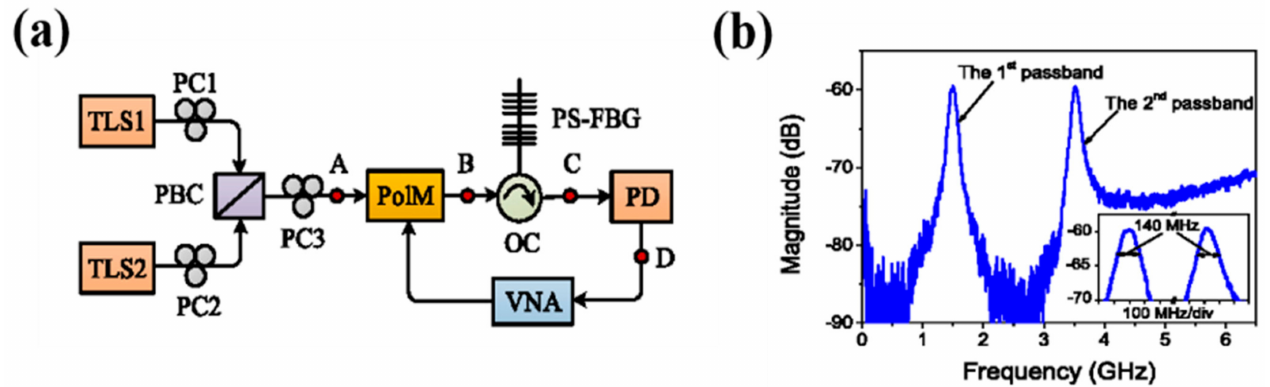
Figure 7. ( a ) Schematic diagram of the dual-passband microwave photonic filter and ( b ) spectral response of the microwave photonic filter. Adapted with permission from ref. [63]. © [2022]